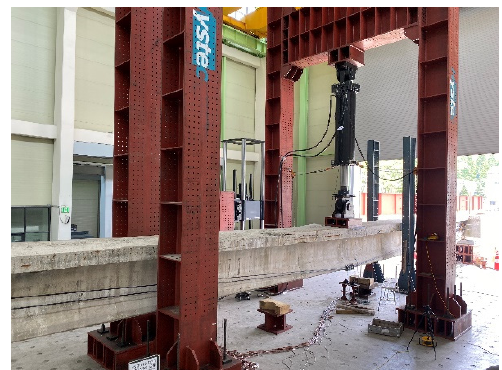
Figure 4. Flexural experimental setup (25 m).